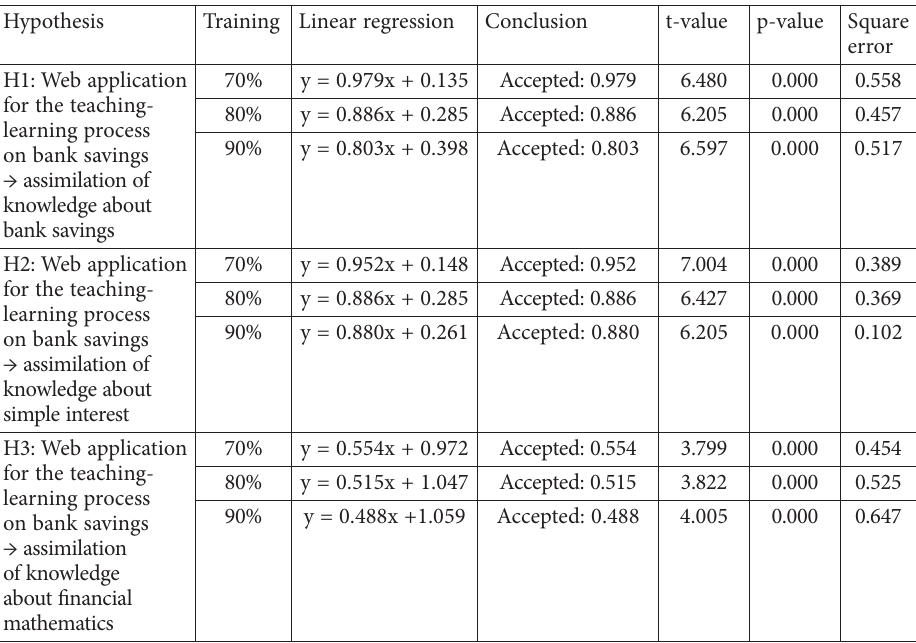
Table 4. Results of machine learning (source: created by authors) Hypothesis